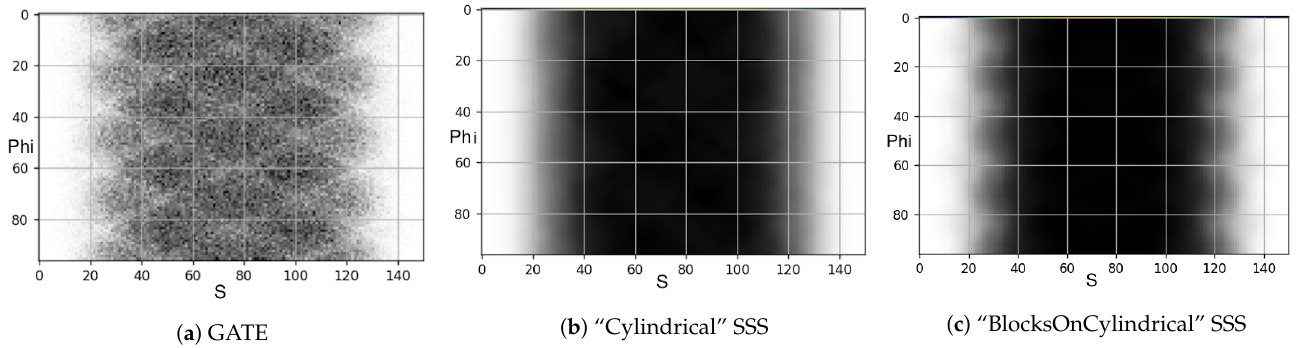
Figure 7. Scatter simulation of the uniform water cylinder: scatter coincidences extracted from the GATE simulations ( a ), STIR’s “Cylindrical” class SSS ( b ), and STIR’s “BlocksOnCylindrical” class SSS ( c ), whose sinogram shape closely matches the shape of the GATE-produced scatter sinogram ( a ) when compared to the sinograms shape computed using the “Cylindrical” class SSS ( b